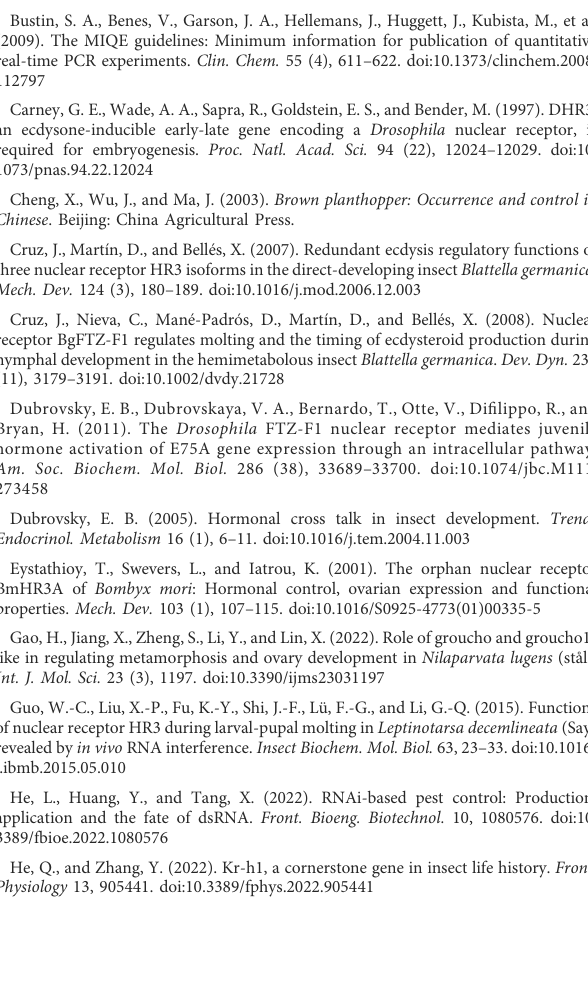
SUPPLEMENTARY FIGURE S2 Splice variant structure comparison. Sequence alignment and phylogenetic tree of FTZ-F1. (A) Prediction of conservative domains and comparison of